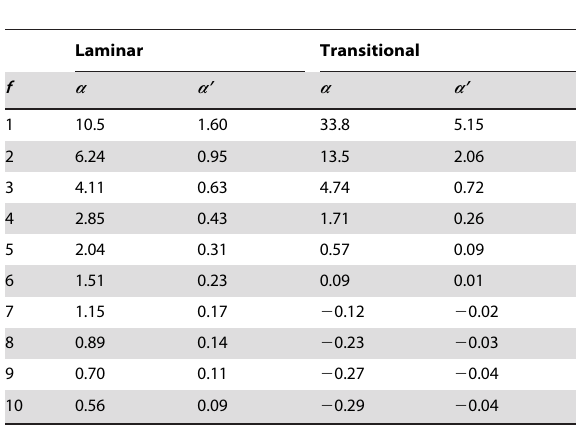
Table 1. Relative cost of change in